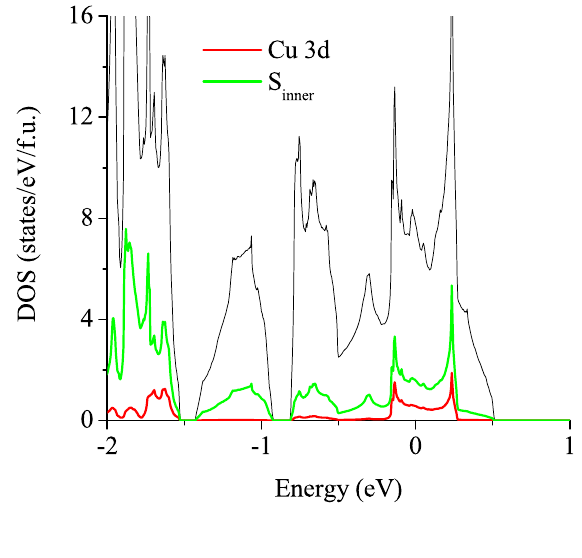
with partial densities of 2 ), inner